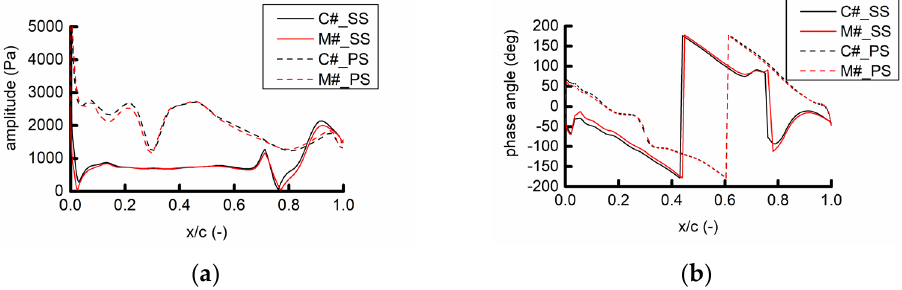
Figure 22. 54 EO component of static pressure at 80% blade span of R1 rotor blade. ( a ) Amplitude ( b ) Phase angle.